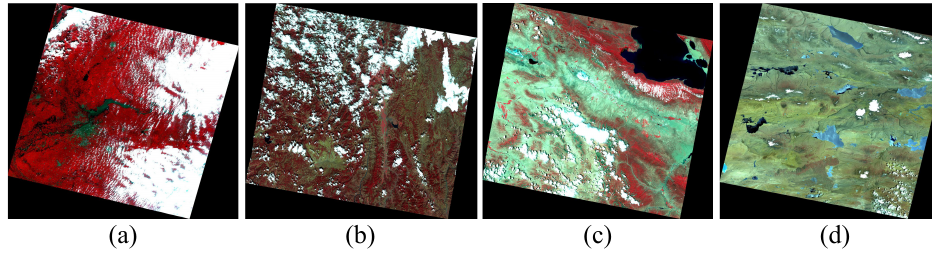
Figure 2. Remote sensing images obtained from the same satellite sensor (GF-1 satellite) at different places. Where ( a ) GF1_WFV2_E127.2_N45.9_20140704_L2A00003099760, ( b ) GF1_WFV1_E102.0_ N28.0_20140302_L2A00002804760, ( c ) GF1_WFV1_E99.4_N36.3_20140716_L2A00002789230, and ( d )